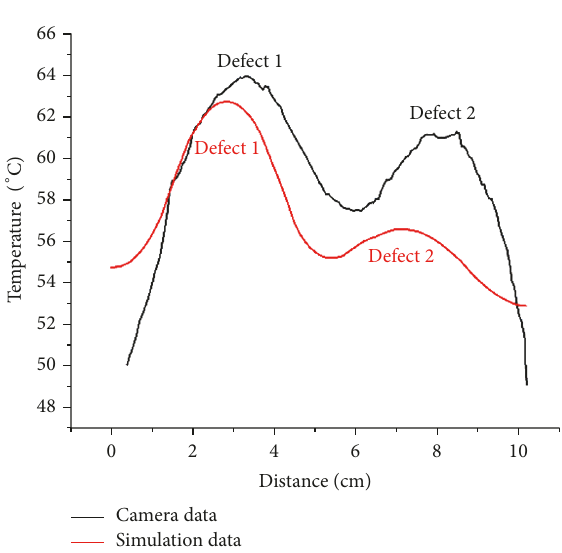
Figure 10: Comparison between the location of defects on both camera and software